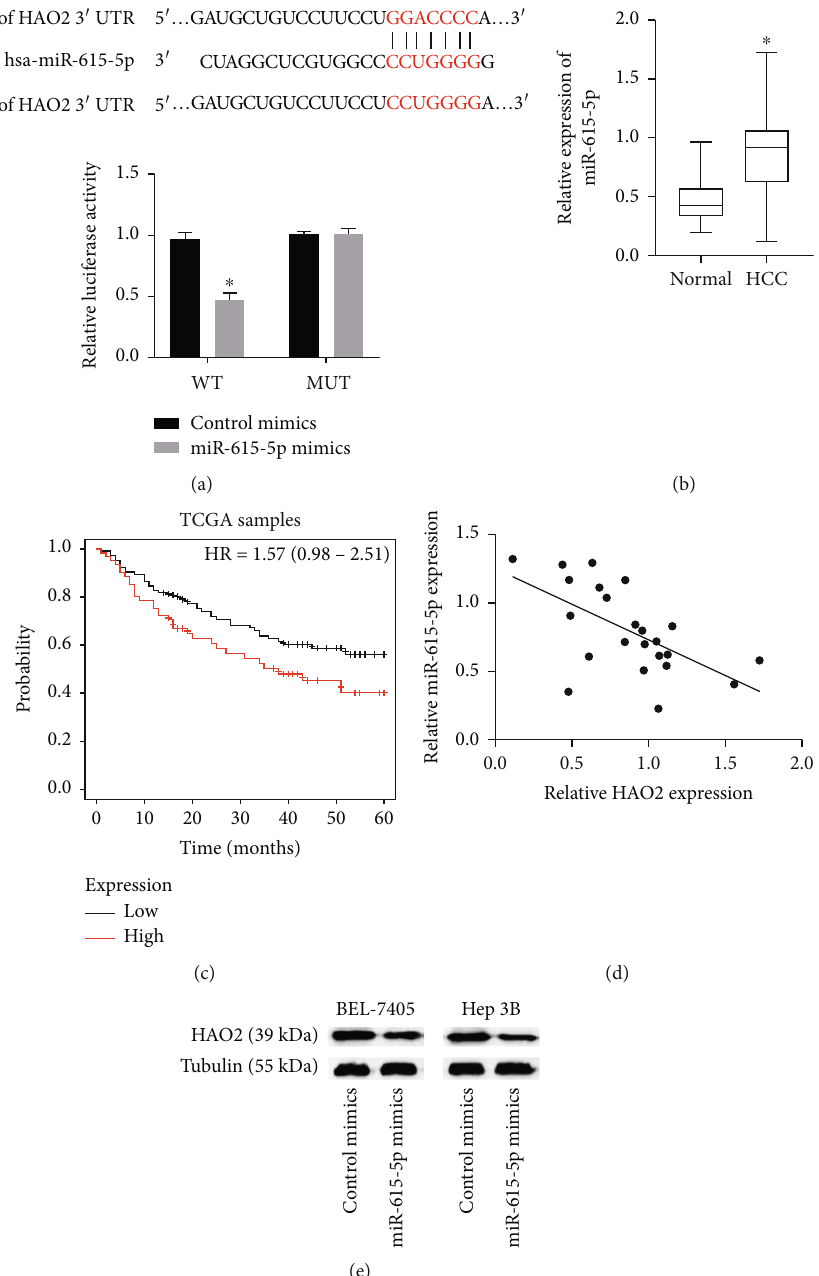
Figure 3: miR-615-5p targets the HAO2 3 ′ UTR. (a) The StarBase online tool and dual-luciferase reporter system experiment indicate that miR-615-5p binds to the HAO2 3 ′ UTR region. (b) The levels of miR-615-5p in 23 pairs of HCC/normal tissues were measured by qRT- PCR. (c) TCGA database analysis of the survival period of high or low miR-615-5p-expressing HCC patients. (d) Negative correlation between the expression of miR-615-5p and HAO2. (e) The expression of HAO2 with miR-615-5p mimics. ∗ P < 0 : 05